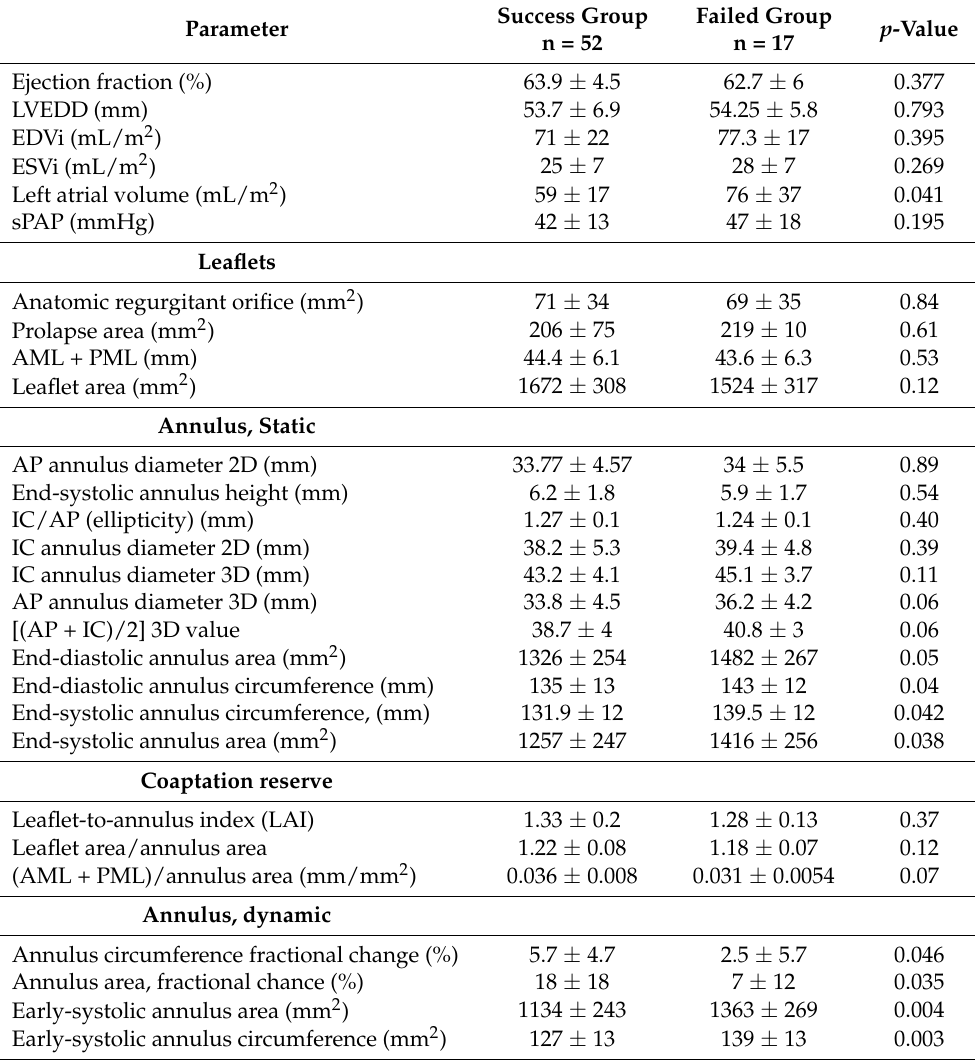
Table 6. Baseline echocardiographic and MV parameters according to residual MR at last